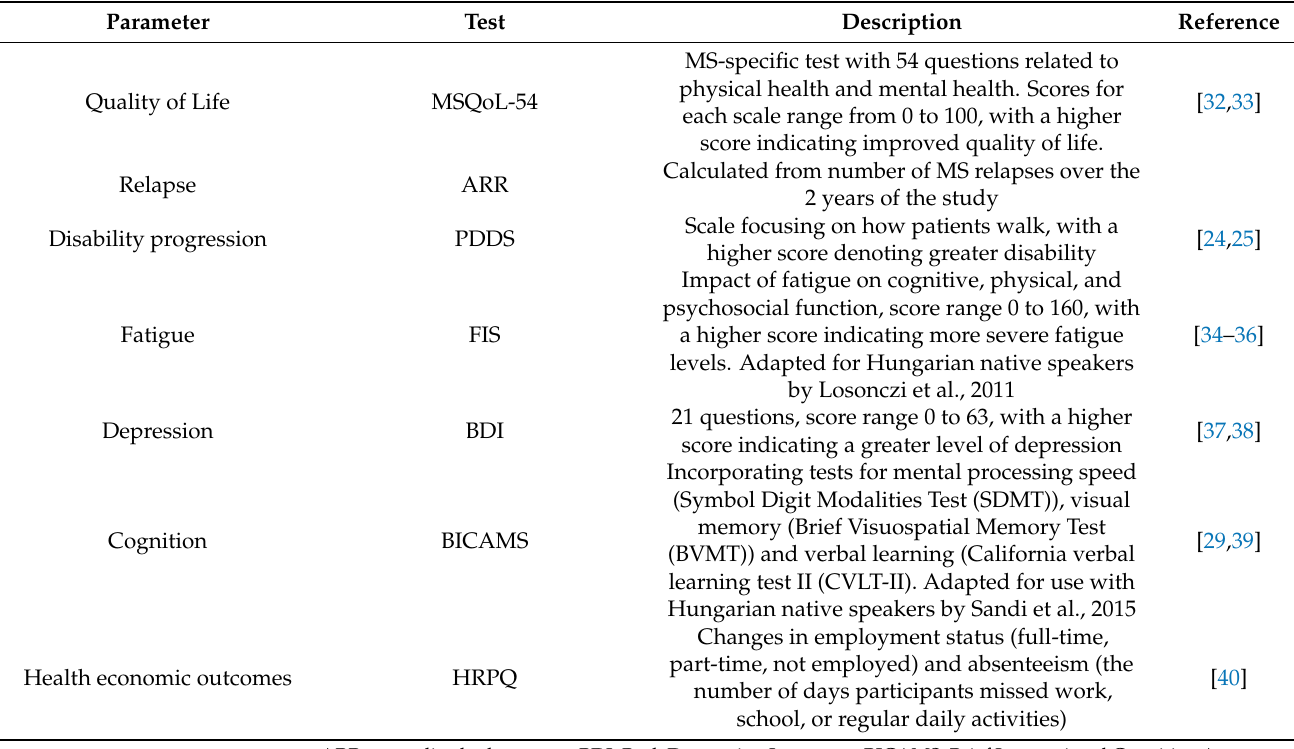
Table 5. Test battery used in